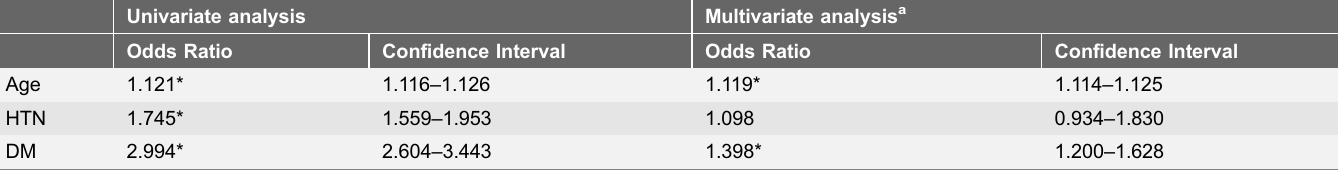
Table 3. Crude and adjusted odds ratios of hearing disturbance among Korean